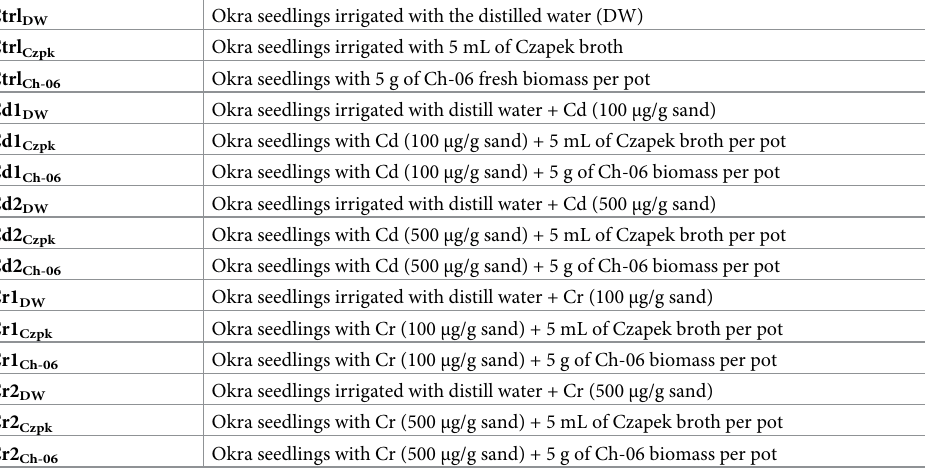
Table 2. Okra seedlings treated with or without Ch-06 CF under Cd and Cr